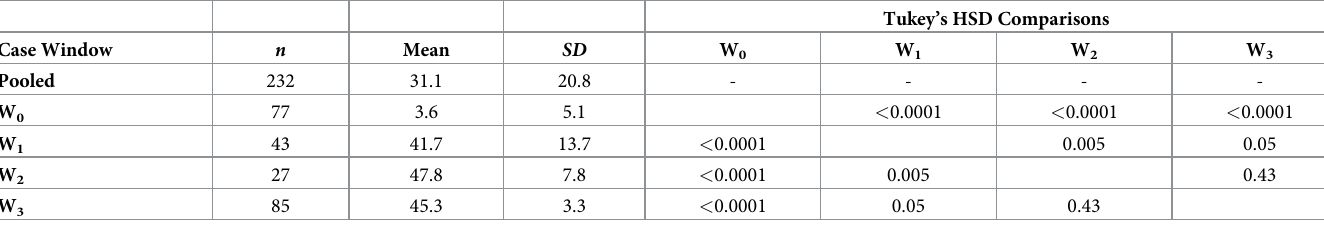
Table 8. One-way analysis of variance of the containment and health index by case window, Zambia.